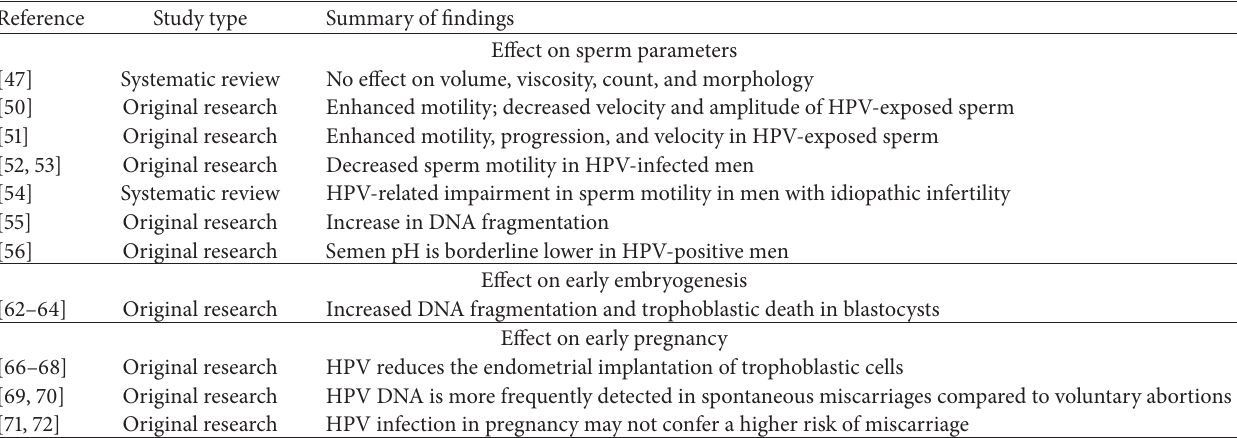
Table 1: Summary of literature pertaining to the effect of HPV on